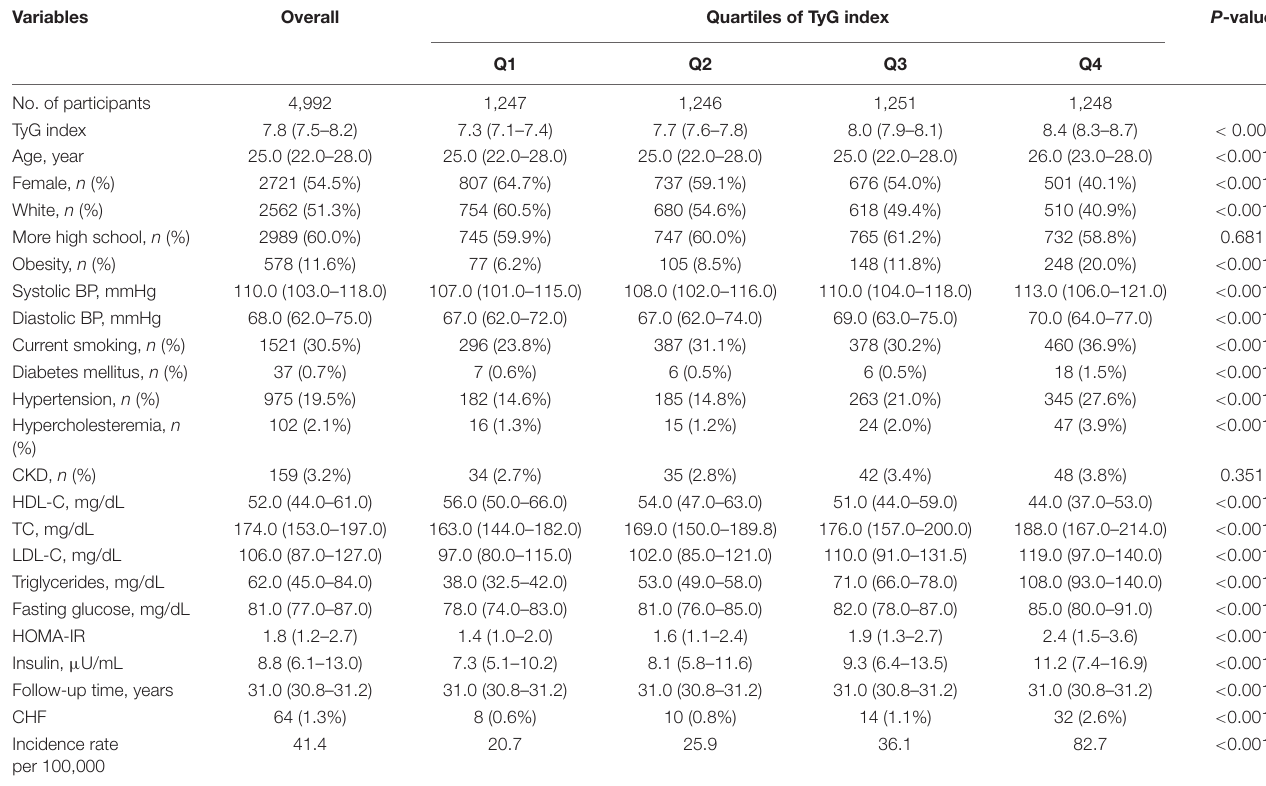
TABLE 1 | Clinical characteristics of the study population according to the TyG index. Variables